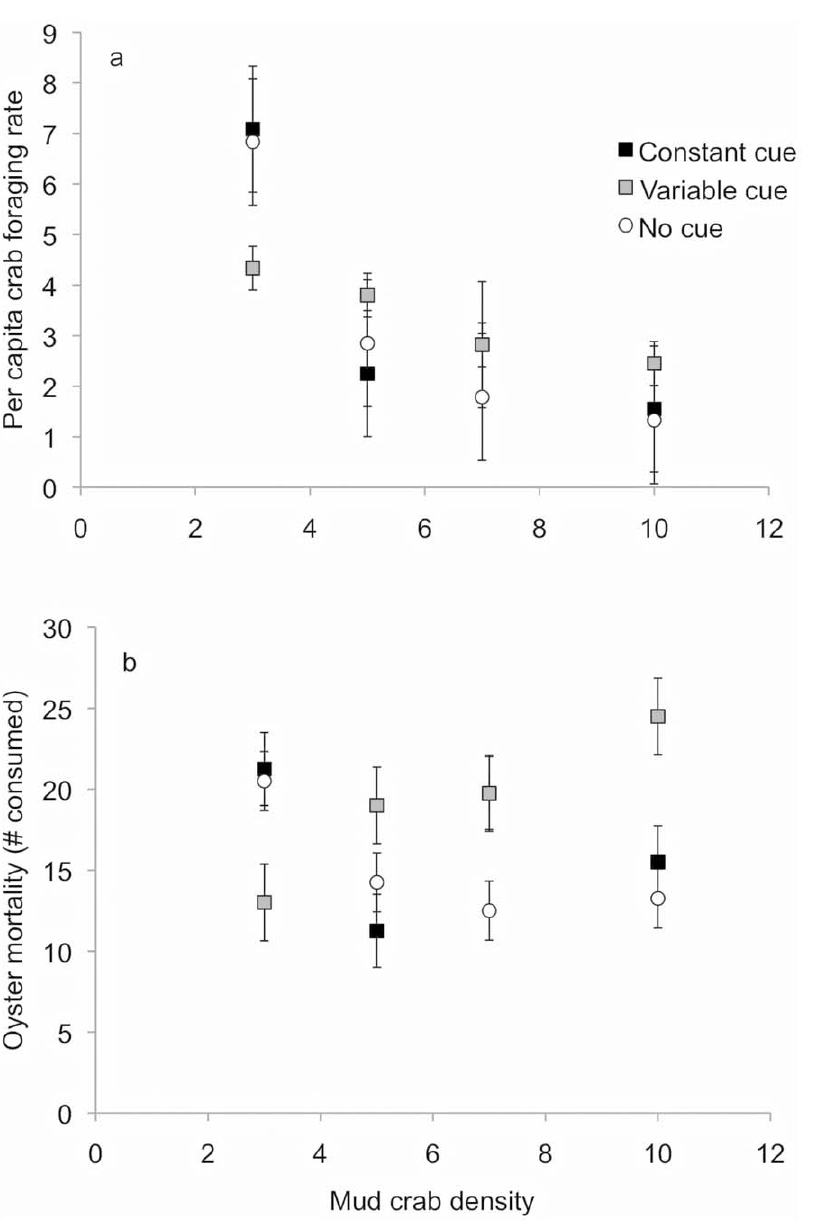
Figure 3. The effects of predator cue and mud crab density on (a) mud crab per capita foraging rate and (b) the number of juvenile oysters consumed during Experiment II. Closed squares indicate predatory fish cue is present at every high tide; gray squares indicate predator cue is present at every other night-time high tide; open circles indicate predator cue is absent at high tide. Symbols represent means( 6 SE). For reference, the average mud crab density in Experiment 1 was as follows: high culling=7.3; low culling=9.0; no